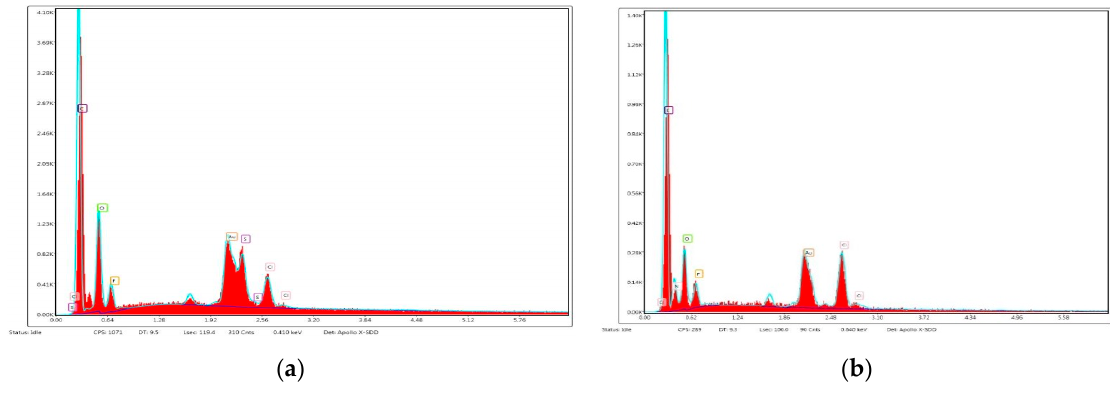
Figure 5. Selected EDX spectra of ( a ) PUR/10PLA/0C and ( b ) PUR/10PLA/5C.